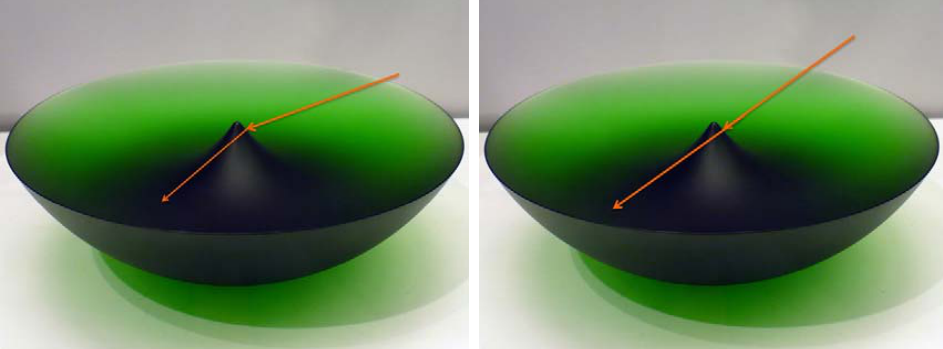
Figure 7. Frantisec Vizner, Bowl, cut and sandblasted. 1984, with approximated light paths superimposed. Photographs by the